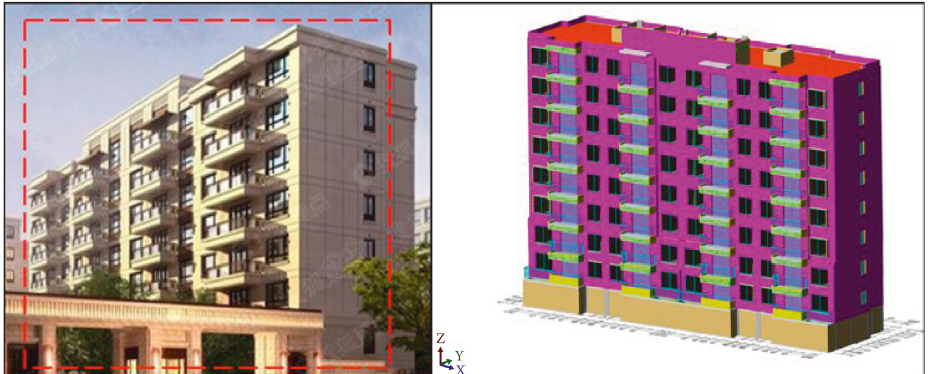
Figure 4: Target building provided by the construction company [37] and architectural rendering developed by the researchers.